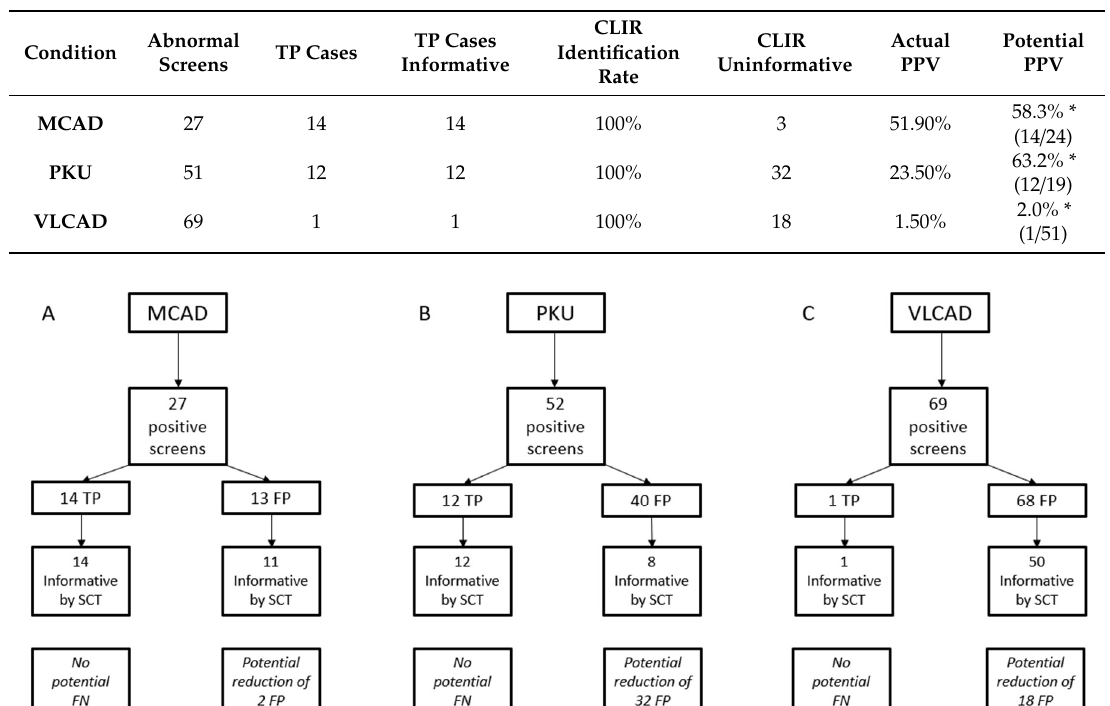
Table 2 . Summary results for isolated screens for MCAD deficiency, VLCAD deficiency, and PKU. *Potential positive predictive values (PPV) considers performance if all uninformative cases had not been reported.